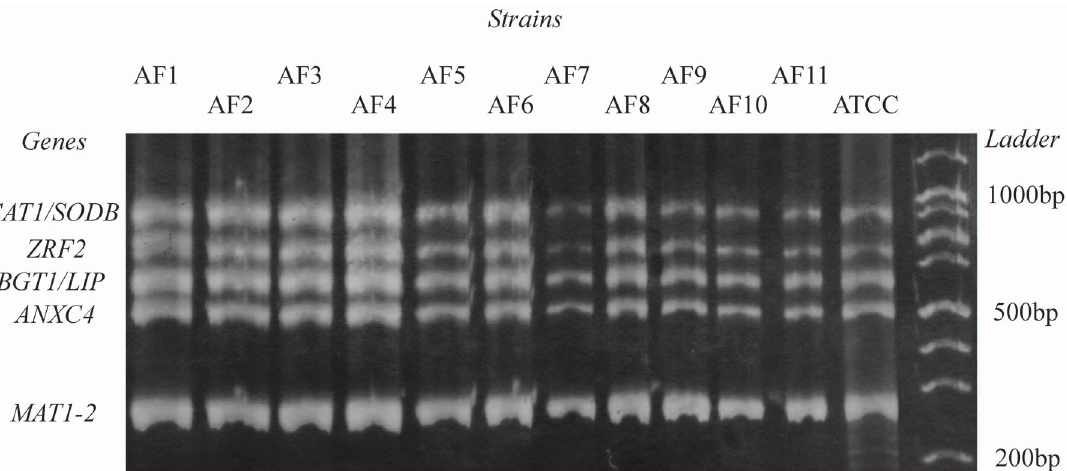
Figure 1. Silver stained polyacrilamide gel showing the band patterns of MLST multiplex amplification. (AF1 to AF11 are A. fumigatus strains from Portuguese collection; reference A.fumigatus ATCC 46645 was added).